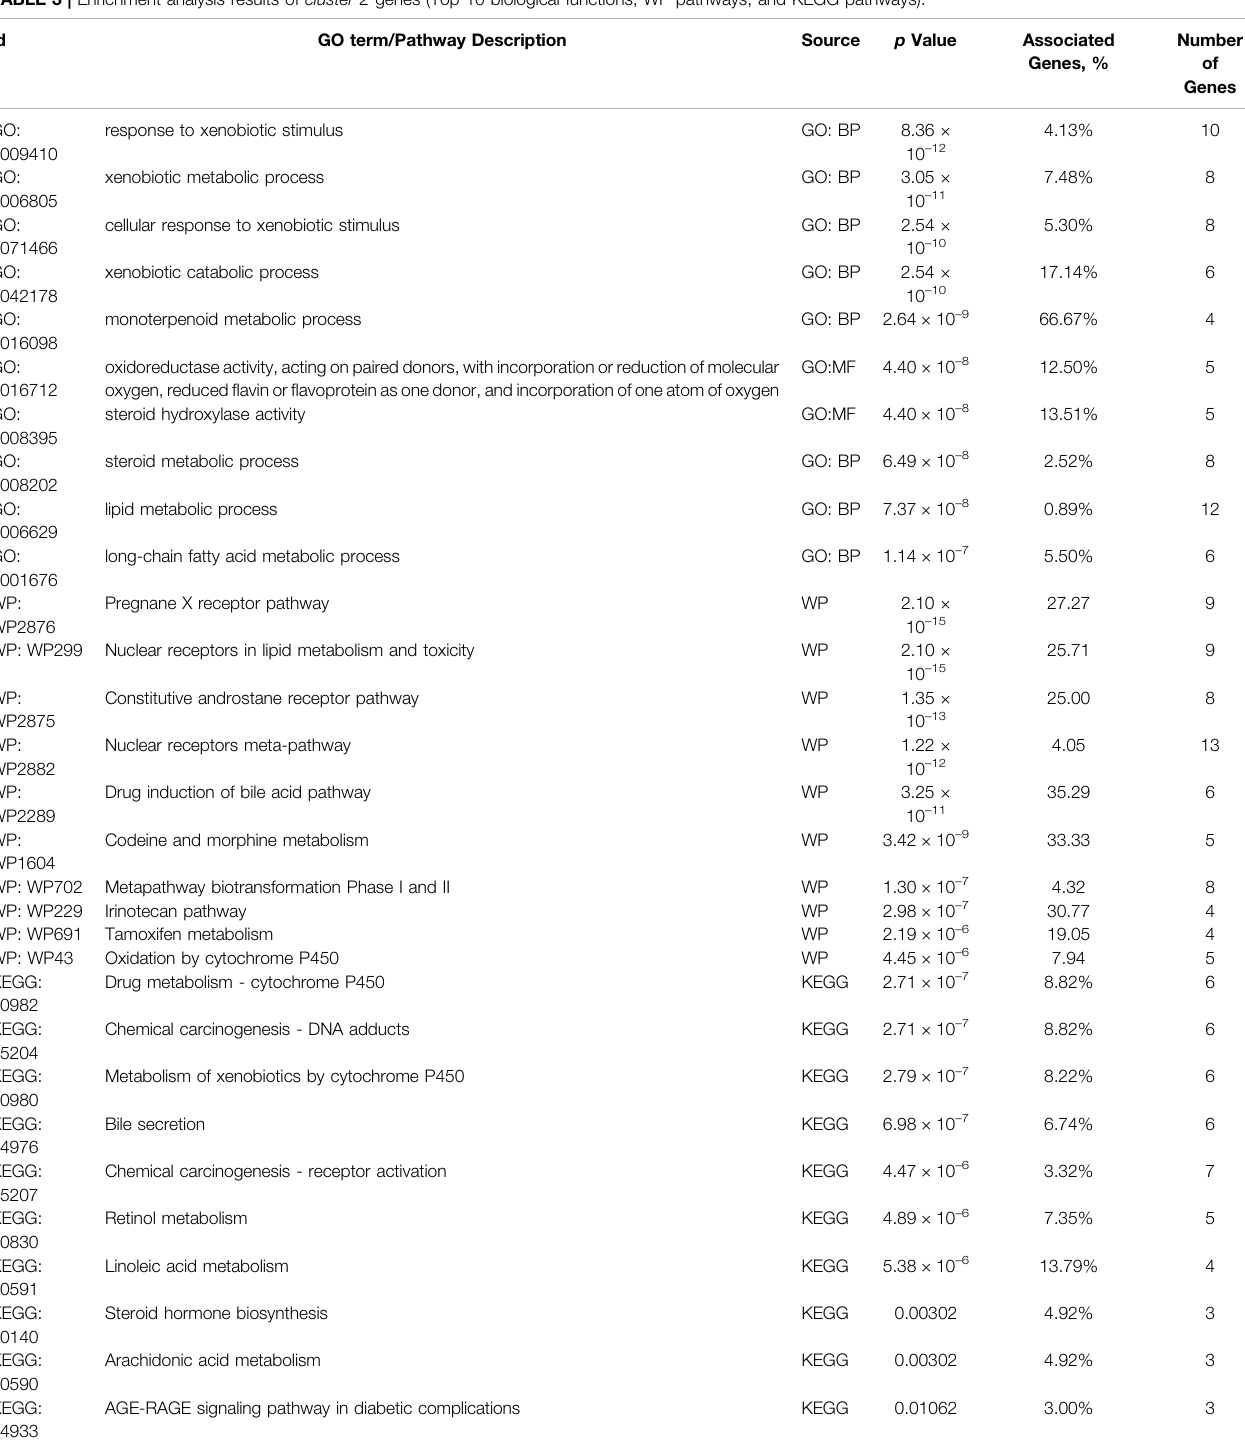
TABLE 3 | Enrichment analysis results of cluster 2 genes (Top 10 biological functions, WP pathways, and KEGG pathways).